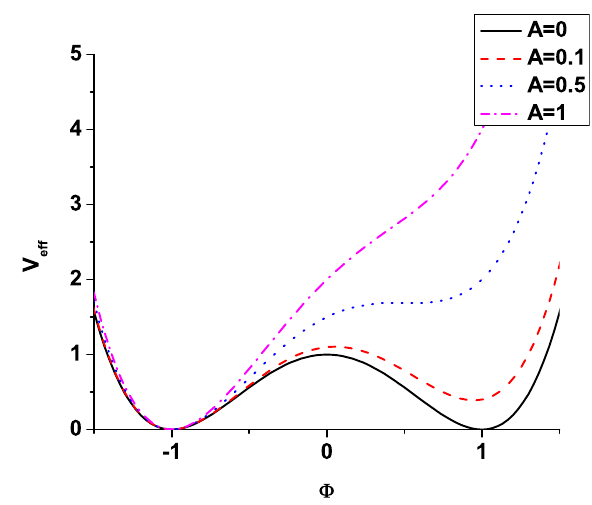
Figure 1 . The effective potential of a scalar field which interacts with a massive object. The solid line (no interaction) shows a potential with two equal minima at φ = ± 1 . The potential and couplings are chosen as in eqs. (2.9) and (2.12) with B = Λ = 1 . The dashed line, A = 0 . 1 , shows a potential with the true vacuum at φ = − 1 and the false vacuum at φ = 1 . For larger values of A there is no false